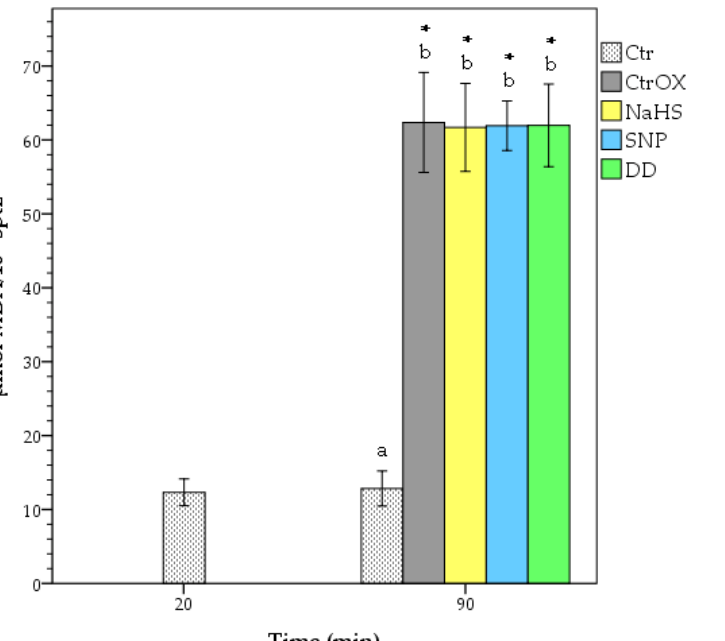
Figure 2. Percentage of membrane intact boar spermatozoa under oxidative stress. Different letters indicate significant differences ( p < 0.05) between treatments at 90 min of incubation. The asterisks indicate significant differences ( p < 0.05) of samples compared to Ctr at 20 min incubation. CTR = control; CtrOX = control under oxidative stress; NaHS = 100 nM; SNP = 100 nM; DD = SNP 100 nM + NaHS 100 nM. Data are shown as mean ± SD of 6 replicates.